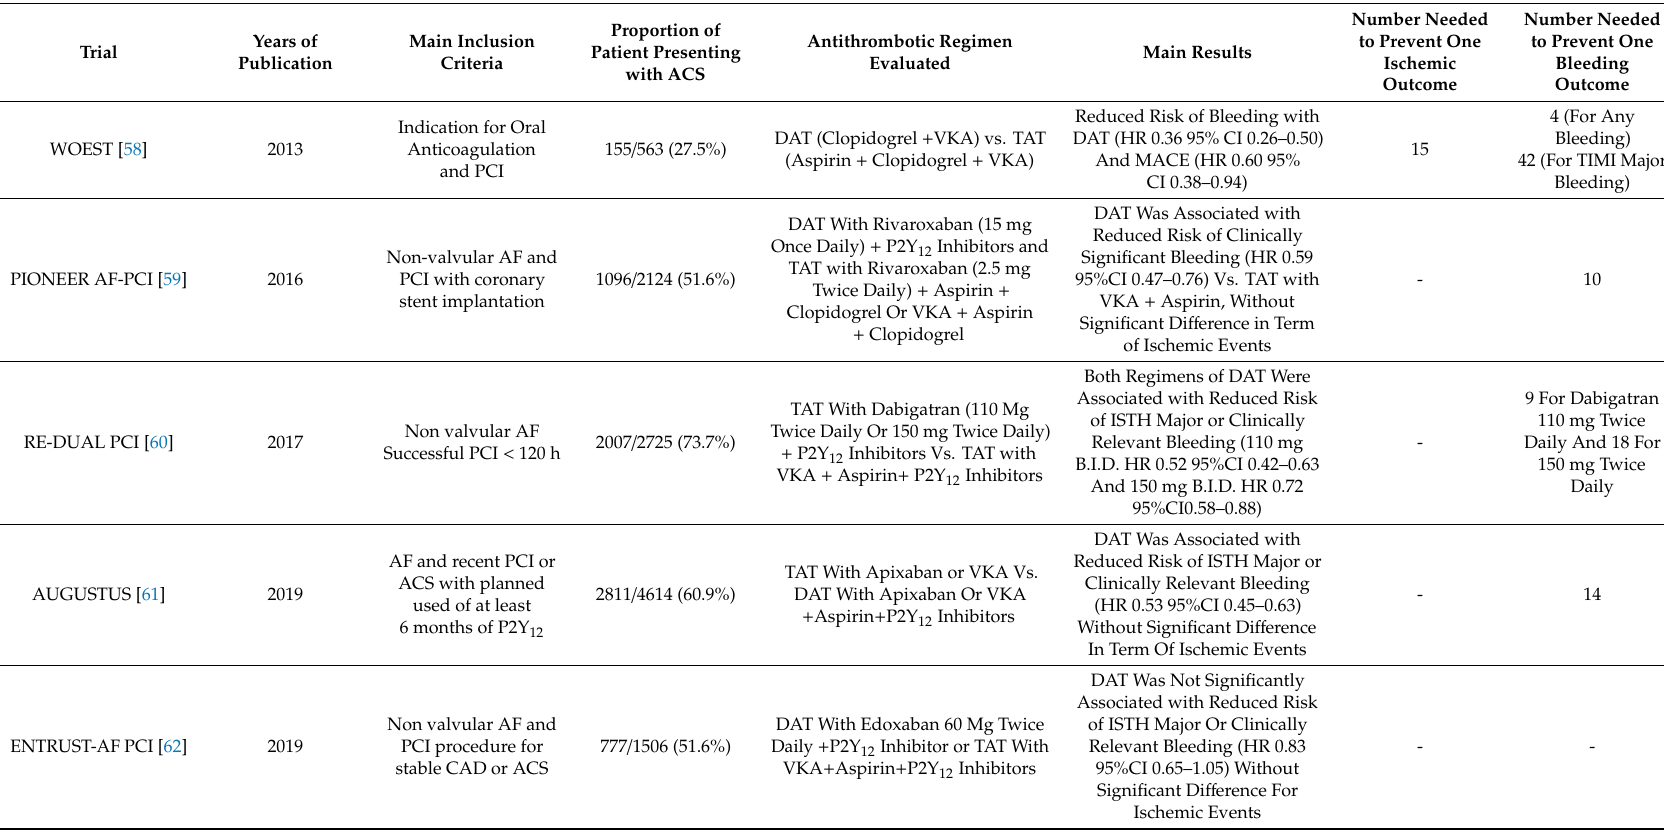
Table 4. Main trials evaluating dual and triple antithrombotic regiment following PCI in patients with long-term indication for chronic oral